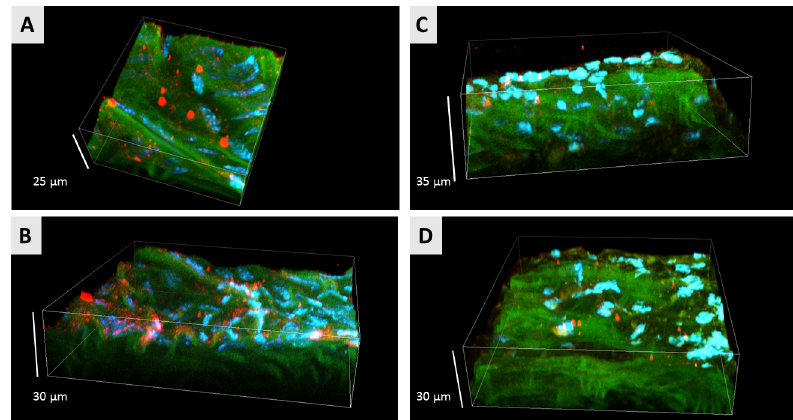
Figure 6. Representative images of lipid rafts obtained using confocal laser scanning microscopy. Two representative confocal micrographs of db/db ( A, B ) and db + ( C, D ) tissue fragments. Endothelial caveolin-1, cell nuclei and elastin fibers are visualized in red, blue and green channels, respectively.